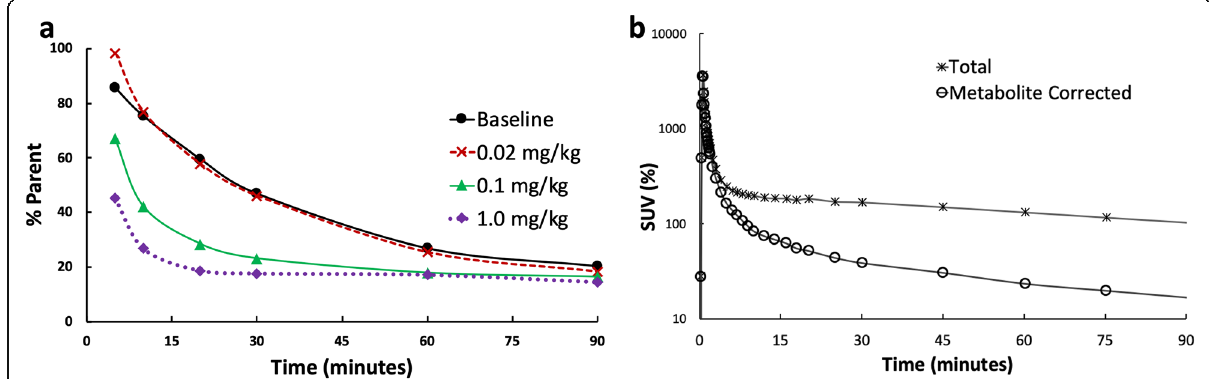
Fig. 2 Radioactive metabolites from four scans (baseline and blocking studies on Baboon3) ( a ), and plasma activity with and without metabolite correction from blocking scan with 0.1 mg/kg dose ( b )